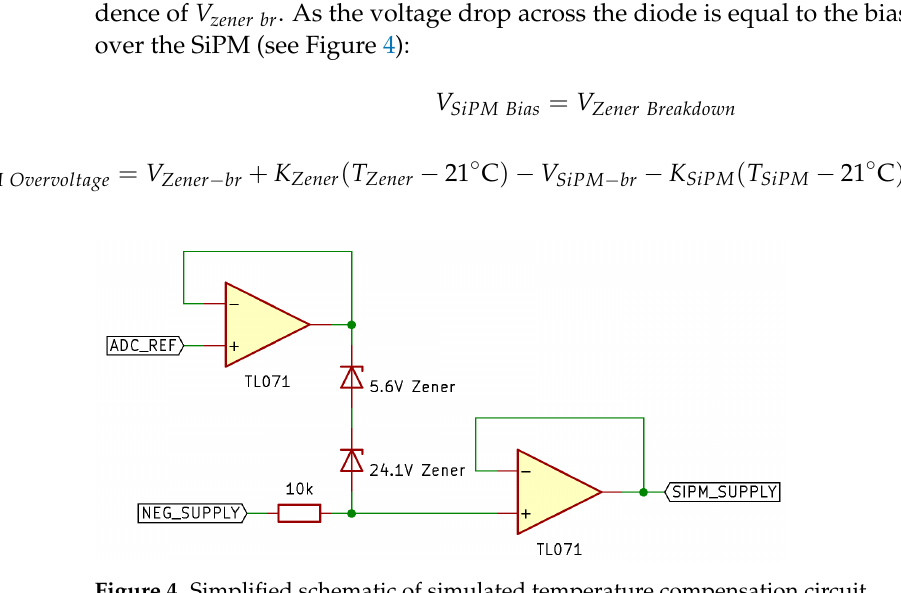
Figure 4. Simpli fi ed schematic of simulated temperature compensation circuit. Figure 4. Simplified schematic of simulated temperature compensation